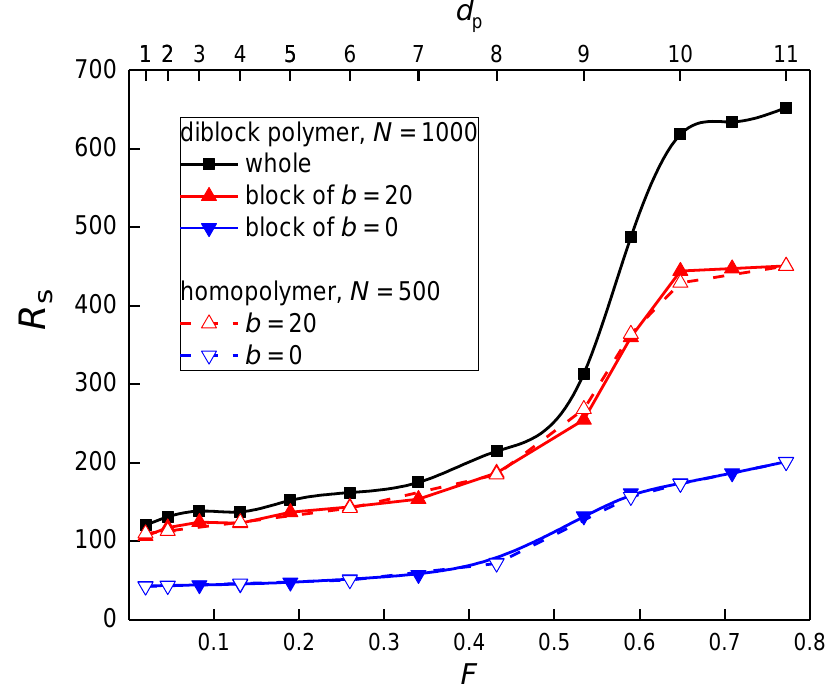
Figure 4. The axial span of a diblock chain, its blocks and homopolymer chains corresponding to the blocks as a function of the filling fraction of posts F or nanopost diameter d p for constant post separation S p = 12.